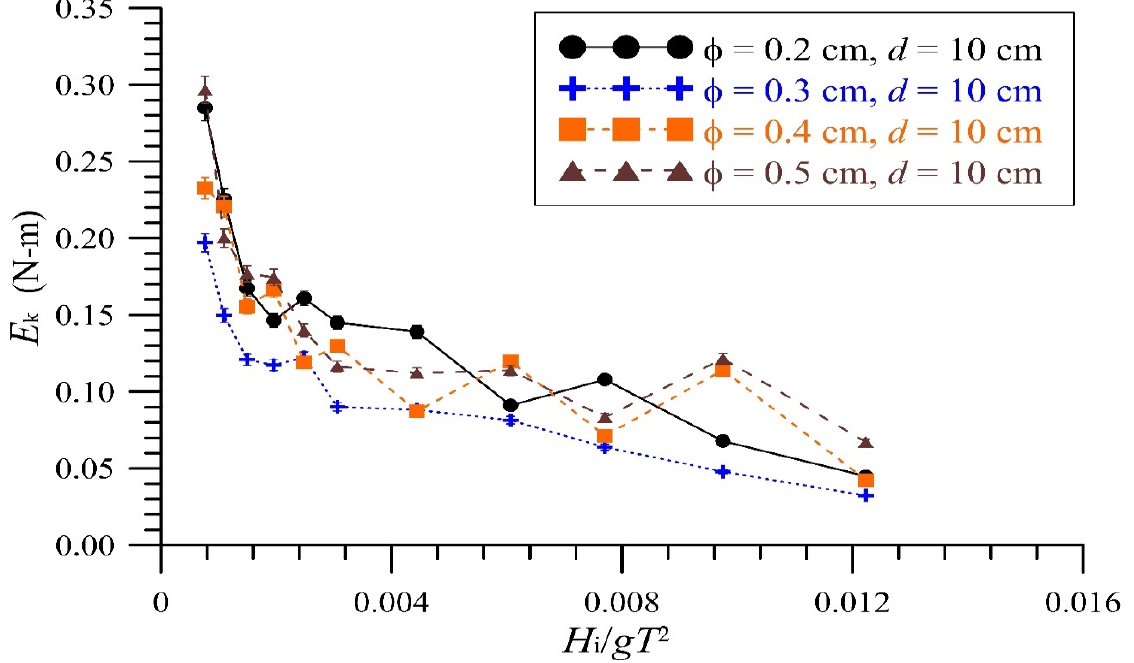
Figure 19. Kinetic energy variations of various waves passing through vegetated areas (plant stem of ϕ = 0.2–0.5 cm and fixed height of d = 10 cm).